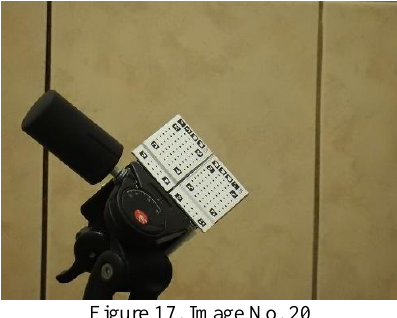
Figure 17. Image No. 20